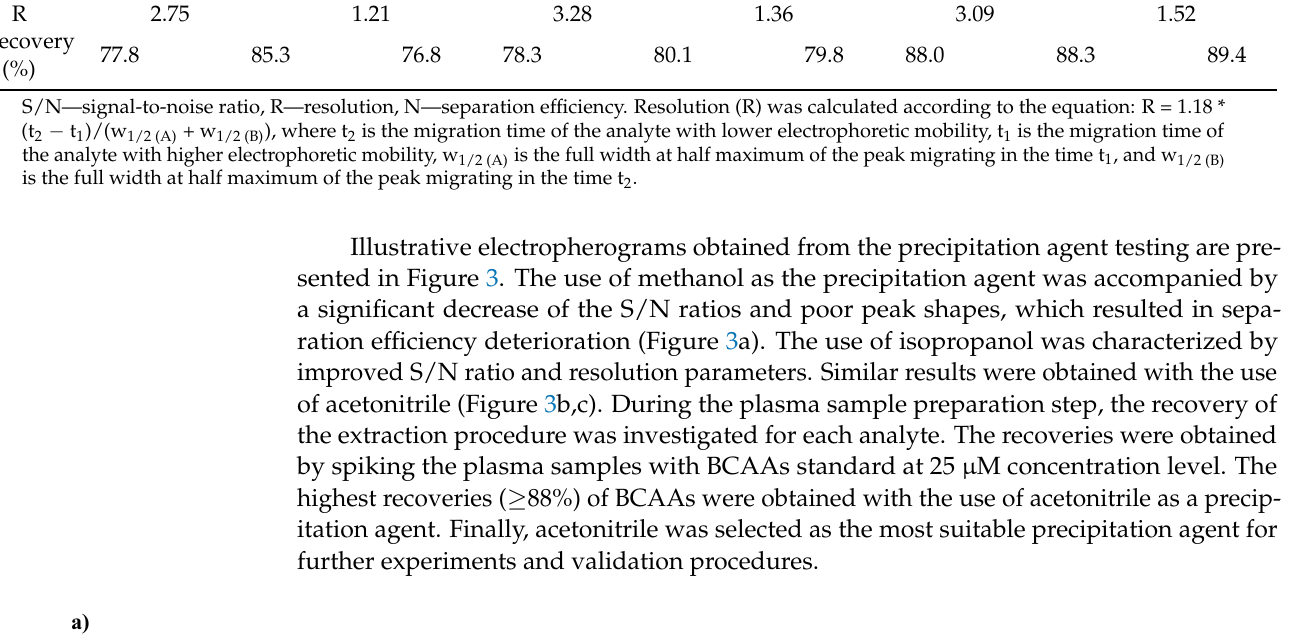
S/N—signal-to-noise ratio, R—resolution, N—separation efficiency. Resolution (R) was calculated according to the equation: R = 1.18 * (t 2 − t 1 )/(w 1/2(A) + w 1/2(B) ), where t 2 is the migration time of the analyte with lower electrophoretic mobility, t 1 is the migration time of the analyte with higher electrophoretic mobility, w 1/2(A) is the full width at half maximum of the peak migrating in the time t 1 , and w 1/2(B) is the full width at half maximum of the peak migrating in the time t 2 .